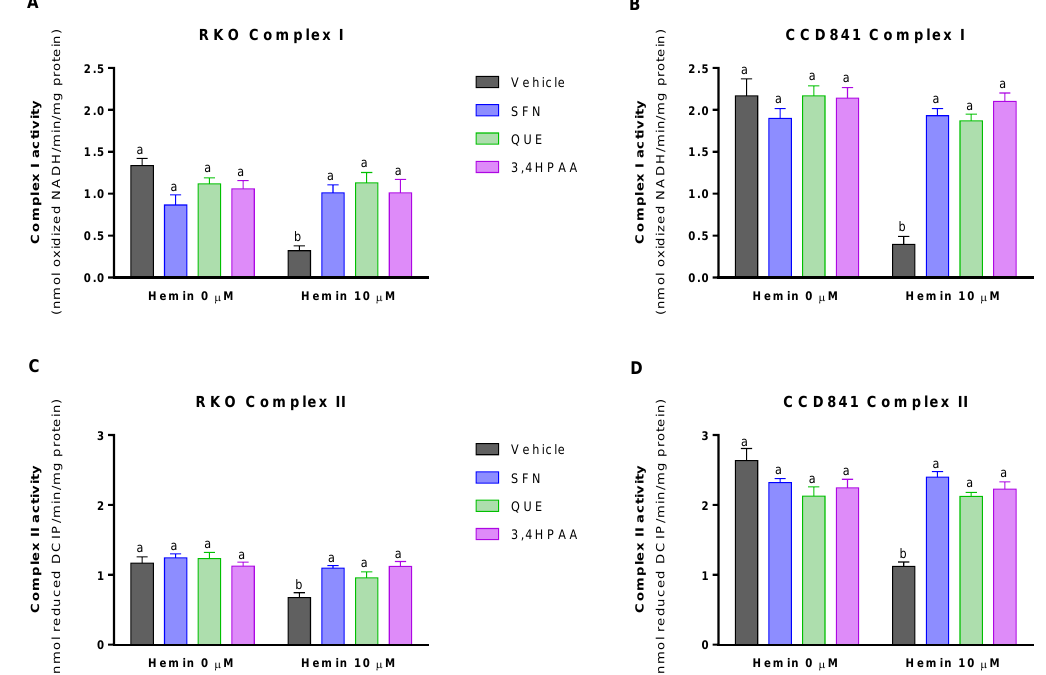
Figure 6. E ff ect of hemin, SFN, QUE and 3,4HPAA in complex I and II activities. Cells were incubated for 72 h with vehicle (0.4% DMSO), 1 µ M SFN, 10 µ M QUE or 2.6 µ M 3,4HPAA in the absence or presence of 10 µ M hemin. Complex I activity was measured in ( A ) RKO cells; and ( B ) CCD841 cells and results were expressed as nmol of oxidized NADH / minute / mg of protein. Complex II activity was measured in ( C ) RKO cells; and ( D ) CCD841 cells and results were expressed as nmol of reduced DCIP / minute / mg of protein. Values are expressed as mean ± SEM, from three independent culture preparations. For all bars with the same letter, the di ff erence between the means is not statistically significant. Values with di ff erent letters indicate significant di ff erences ( p < 0.05) between bars (two-way ANOVA, Bonferroni post-test). 3,4HPAA, 3,4-dihydroxyphenylacetic acid; DCIP, 2,6-dichlorophenolin-dophenol; QUE, quercetin; SFN, sulforaphane.